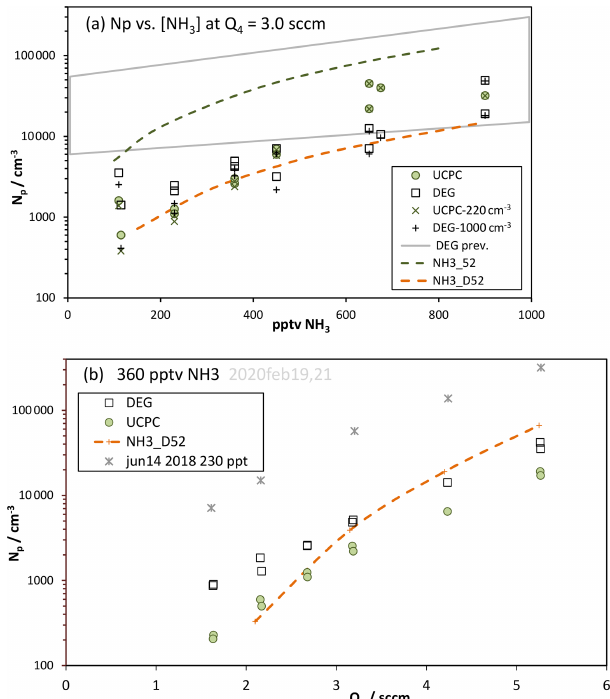
Figure 6. N p vs. (a) ammonia level and (b) Q 4 . (a) Experimental data for the two particle detection systems, minus the zero-added base N p , are plotted as the squares (DEG) and diamonds (M1), and the gross N p is also shown. Model-predicted N p (binary N p is neg- ligible) is shown as the green (NH3_52) and orange (NH3_D52) dashed lines. Clusters up to 10 acid molecules and either three or six ammonia molecules were simulated; runs with six ammo- nia molecules were within 3% of runs with three. The Supple- ment has further details of the model runs. The gray quadrilateral “DEG prev.” encompasses data from Fig. 5 of Hanson et al. (2019). (b) Symbols as in (a) with NH 3 present at 360pptv. Asterisks are previous data (Hanson et al., 2019) from 14 June 2018 at 230pptv NH 3